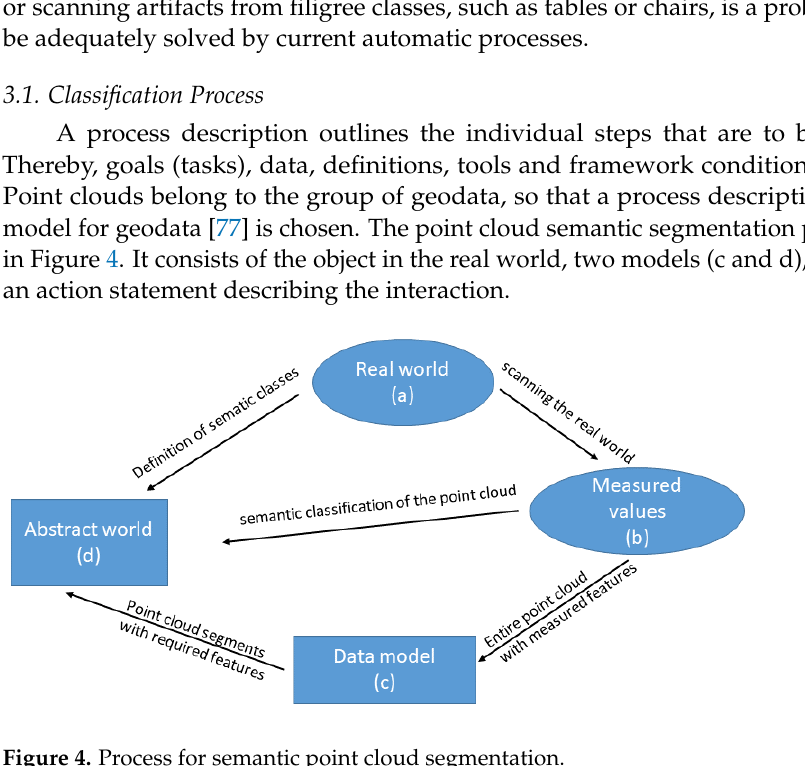
Figure 4. Process for semantic point cloud